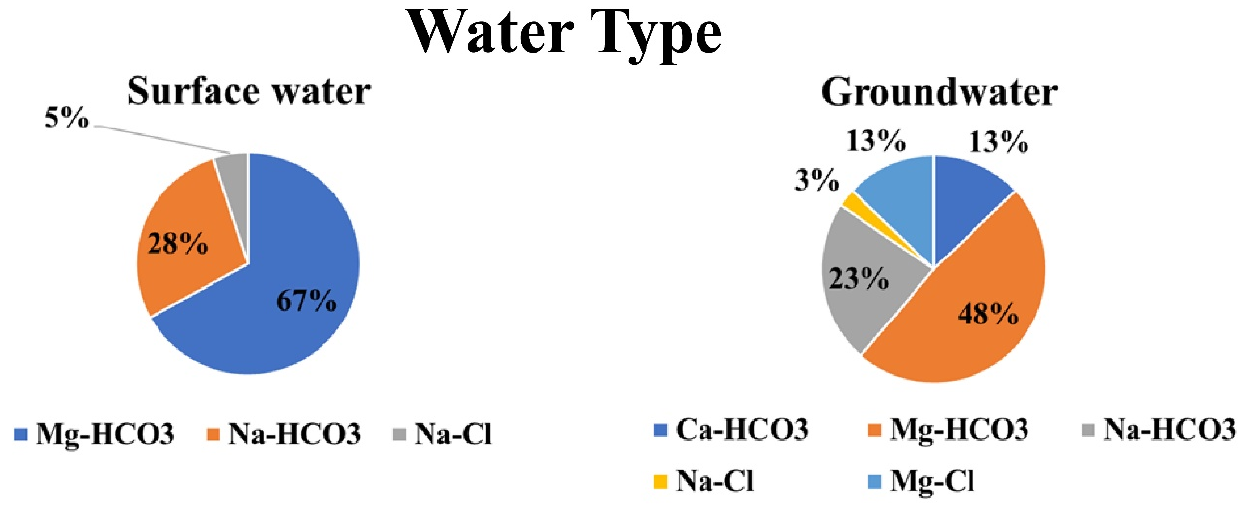
Figure 7. Water types of the studied water samples.